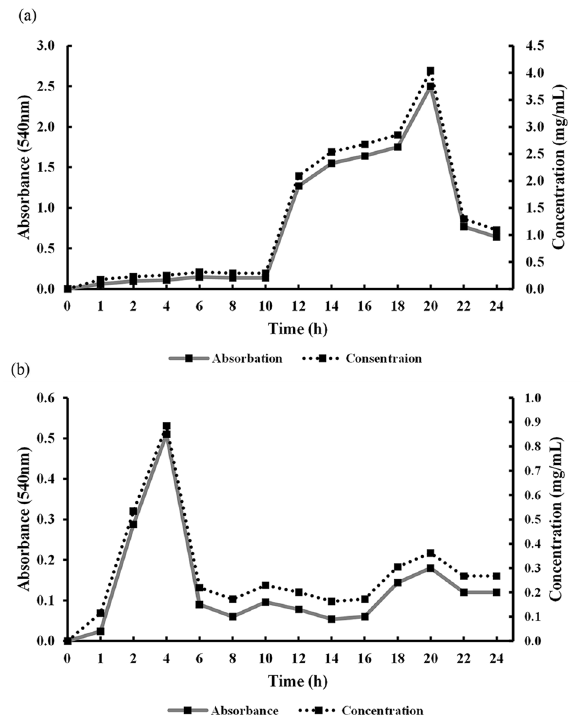
Figure 2. Monitoring amount of pectic oligosaccharide released from ( a ) A. faecalis AGS3 isolate, and ( b ) P. polymyxa S4 isolate, in pectin culture medium—30 °C 180